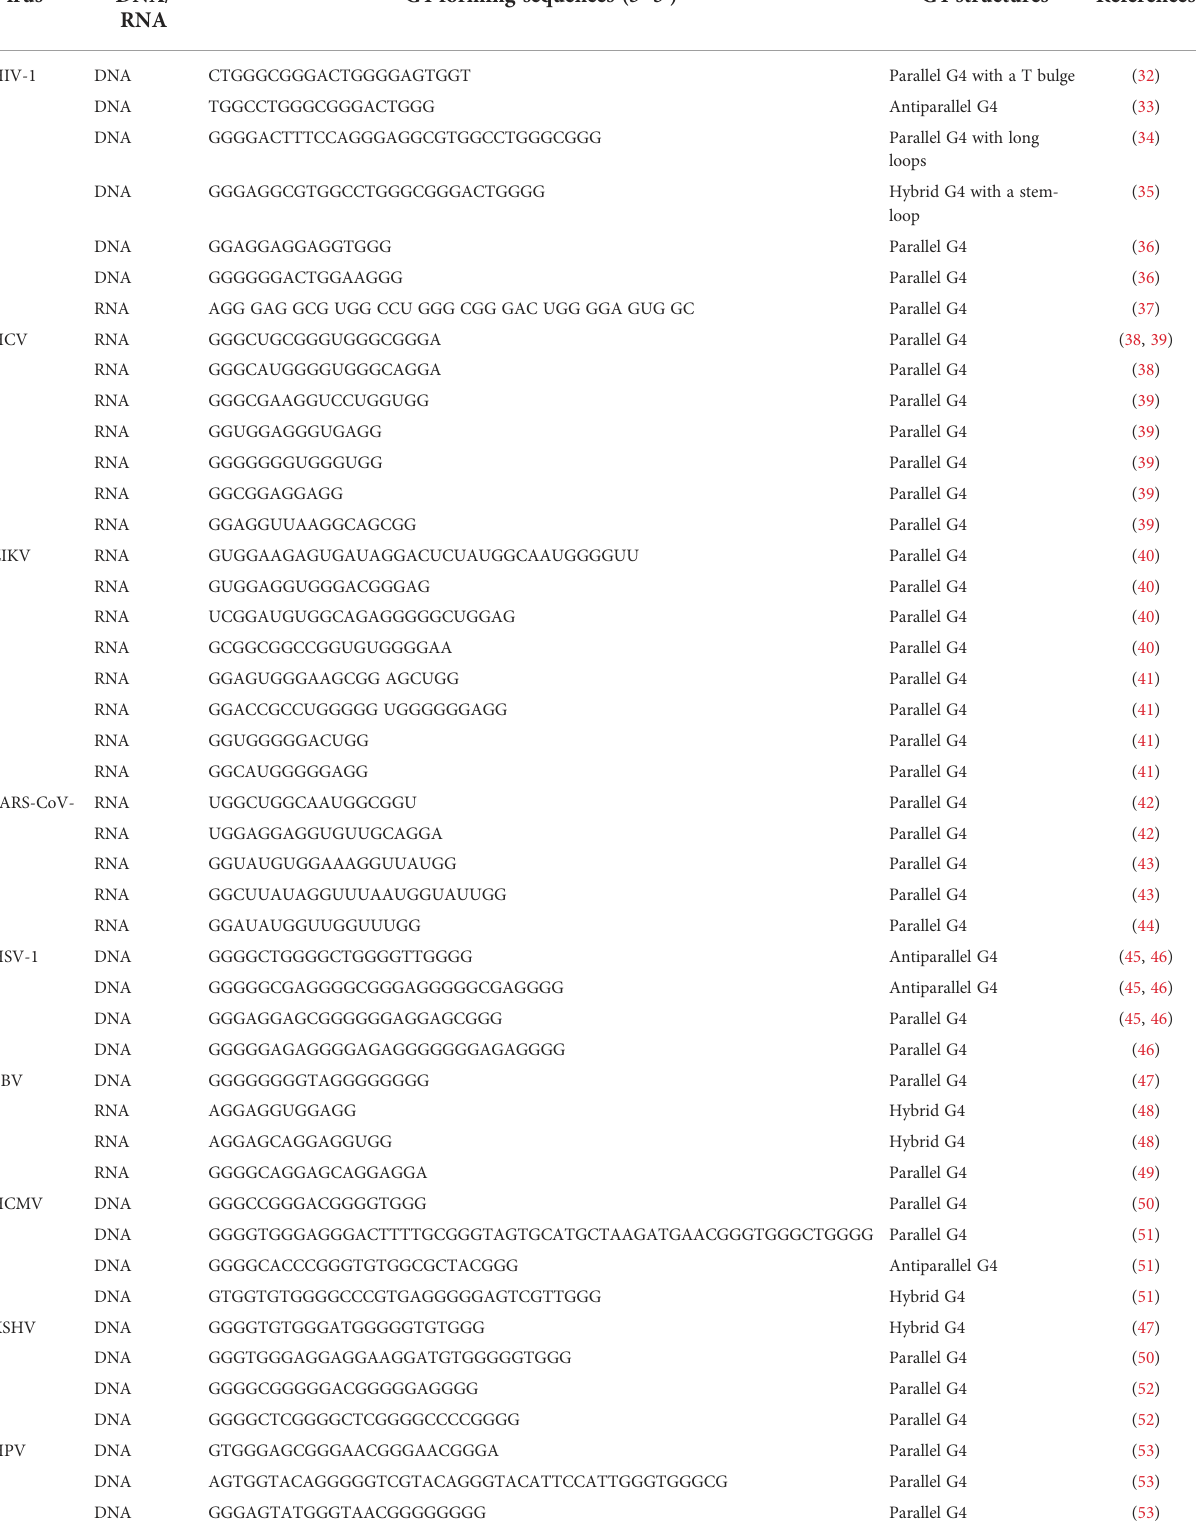
TABLE 1 Examples of G4 forming sequences with structural characterization in different viral genomes. Virus DNA/